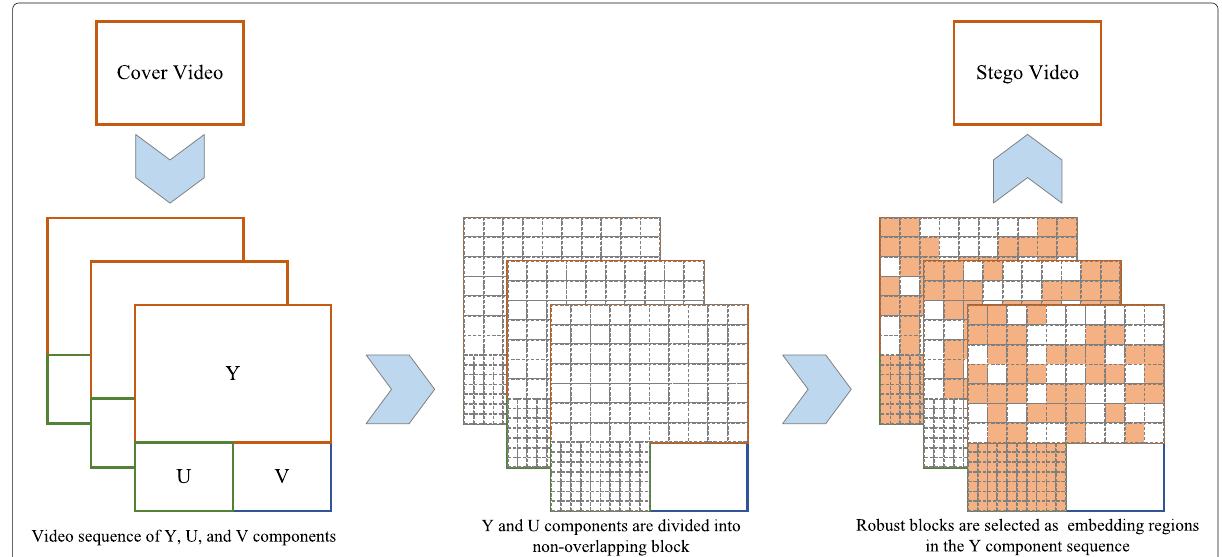
Fig. 9 The schematic diagram of joint embedding based on the Y and U components. Orange blocks represent PCA-selected regions, and white blocks represent unselected